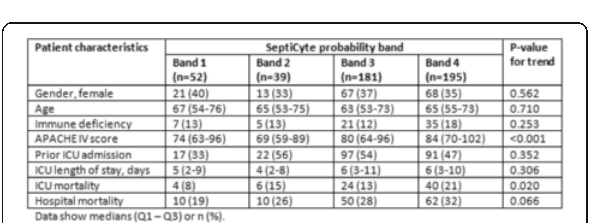
Table 8 (abstract A7). Demographic characteristics